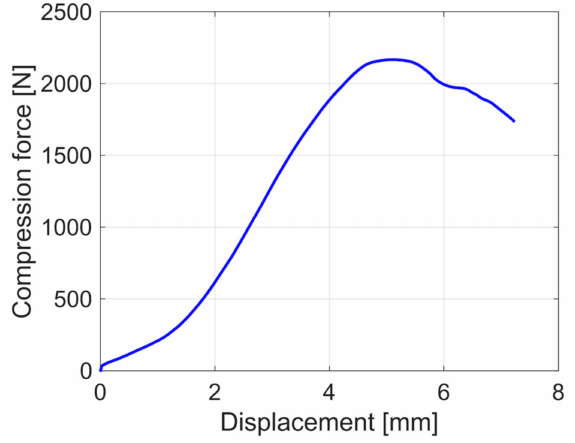
Figure 6. Typical BCT force–deformation